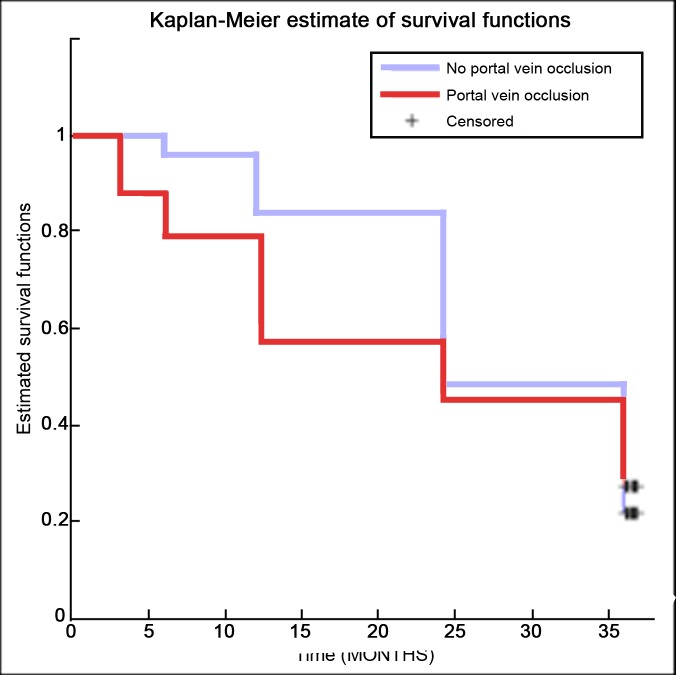
Kaplan-Meier survival curves comparison of patients without portal thrombosis and those with portal vein thrombosis, whether or not the obstruction was in the main trunk or in a peripheral branch.